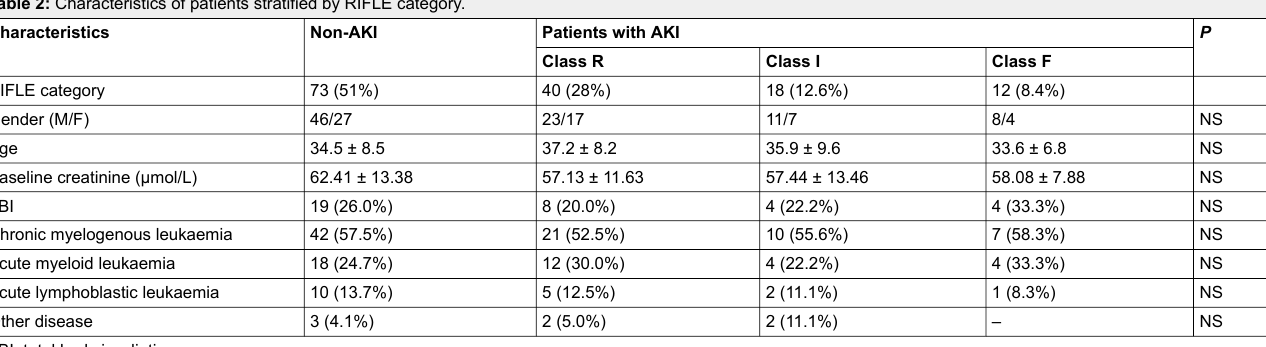
Table 2: Characteristics of patients stratified by RIFLE